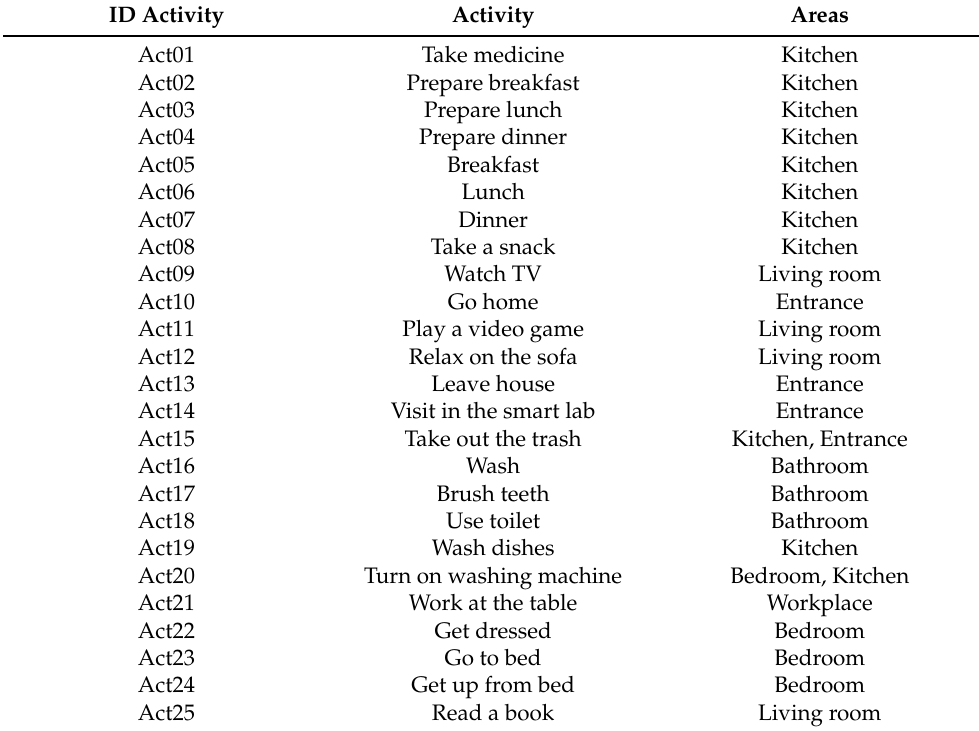
Table 1. Correspondence between activity and area.